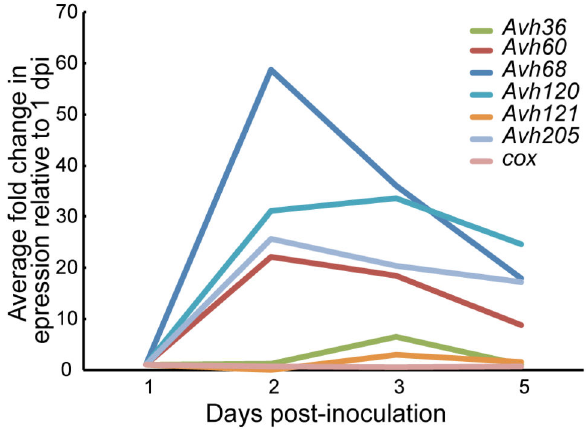
Figure 7. Expression of four RXLR effector genes in Rhododendron leaves infected with P. ramorum . In lineage NA1 isolate Pr-102, the genes PrAvh60 , PrAvh68 , PrAvh120